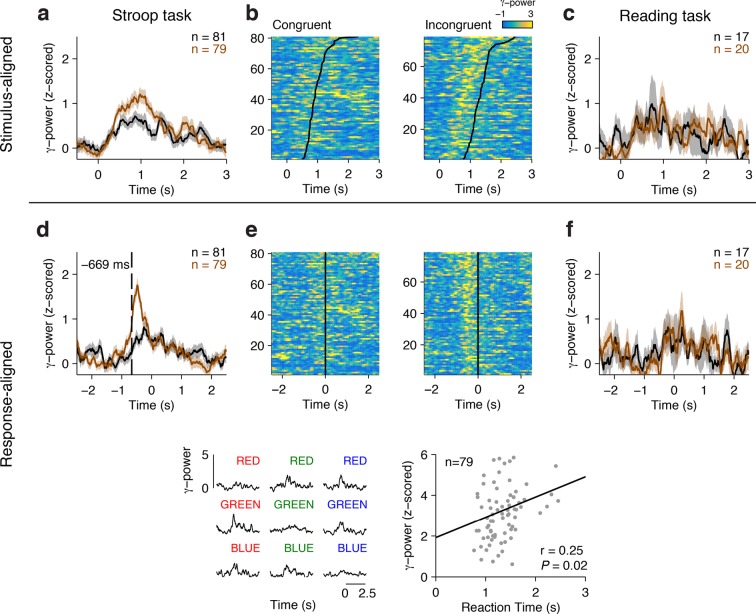
Example electrode in left Anterior Cingulate Cortex.(A) Average gamma power signals aligned to the stimulus onset from an electrode during the Stroop task, for congruent (black) or incongruent (brown) stimuli. For display purposes only, we z-scored the gamma power by subtracting the average and dividing by the standard deviation of power during the baseline period (500 ms prior to stimulus onset). Shaded areas indicate s.e.m. The total number of trials for each condition is indicated in the upper right. (B) Single-trial data for congruent (left) and incongruent (right) trials. Each row is a trial, and the color indicates the z-scored gamma power (color scale on upper right). Trials are sorted by behavioral response time (black line). (C) Same as (A), but showing data from the Reading task. (D-F) Same as in A-C, but aligning the data to behavioral response time. Gamma power was better aligned to the behavioral response, and was stronger for incongruent compared to congruent trials. The dashed line indicates the response-aligned latency, defined as the first time point at which incongruent and congruent trials can be discriminated. (G) Signals elicited by each of the 9 possible stimulus combinations. (H) There was a correlation between the maximal z-scored gamma power and behavioral reaction times during incongruent trials (Pearson correlation coefficient = 0.25, P = 0.02, permutation test). Each point in this plot represents a single trial.DOI:
http://dx.doi.org/10.7554/eLife.12352.00610.7554/eLife.12352.007Figure 2—source data 1.Conflict-selective electrode data.